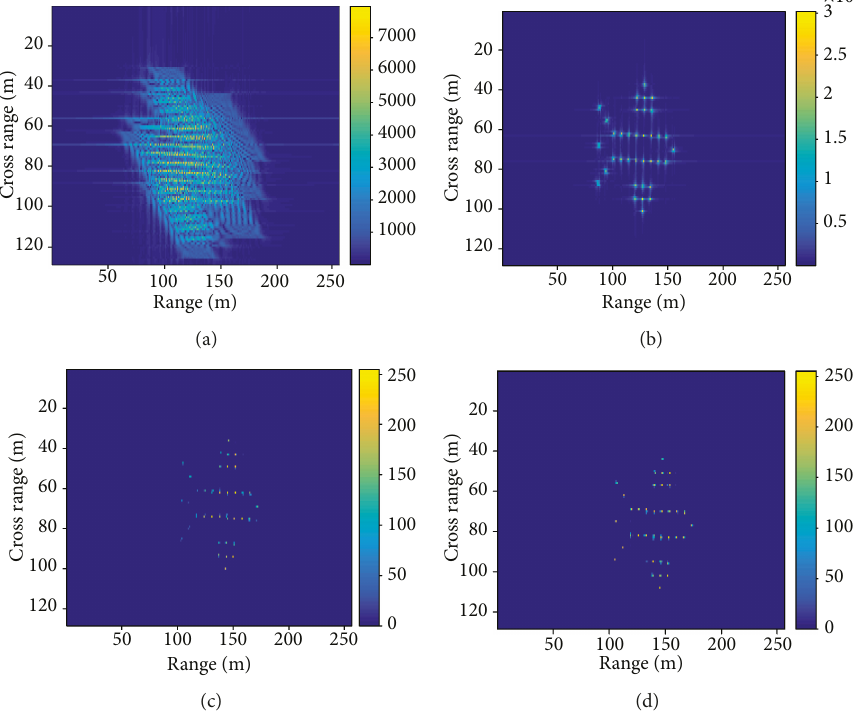
Figure 9: Imaging results with the target ’ s motion parameters P5. (a) RD algorithm. (b) Minimum entropy method. (c) OSS phase retrieval algorithm. (d) The proposed